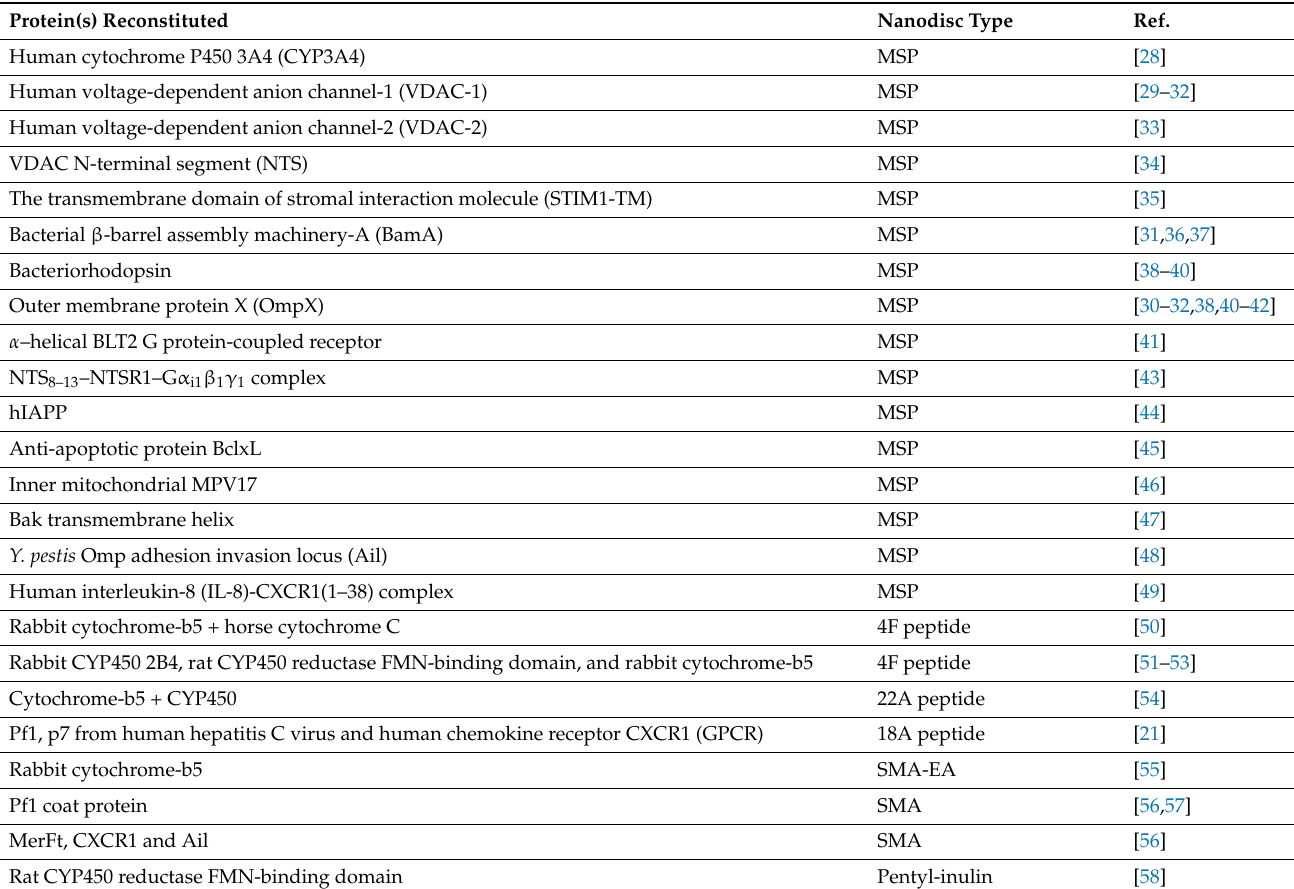
Table 2. List of membrane proteins reconstituted in nanodiscs and studied by NMR